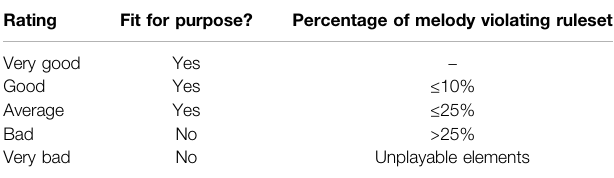
TABLE 4 | Criteria for assigning each generated sight reading exercise a